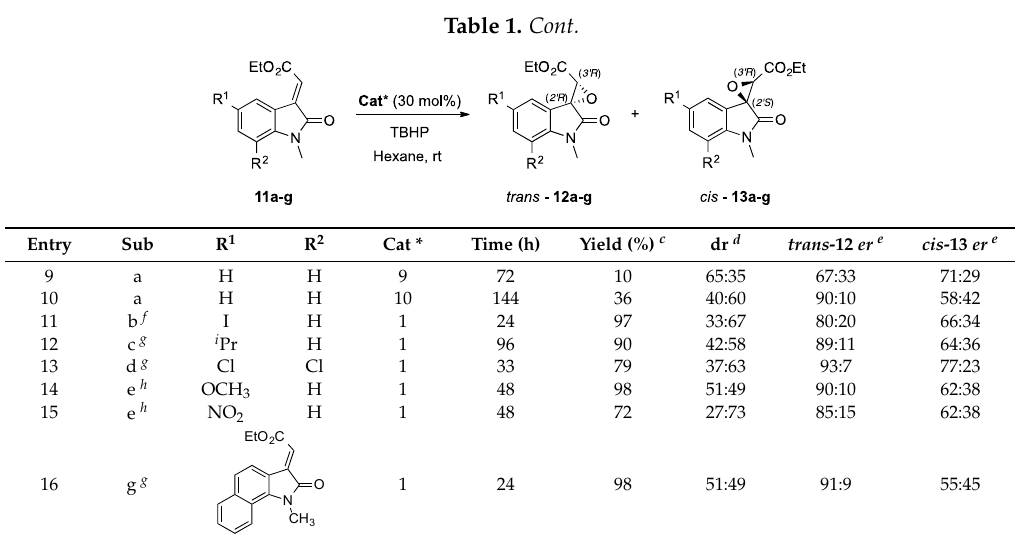
a Reaction conditions: N -Methyl α -ylideneoxindole 11 (0.5 mmol), catalyst 1 (0.15 mmol), THBP (0.6 mmol), and high-performance liquid chromatography (HPLC) grade hexane (2.7 mL) at rt. b The given stereochemical assignments are based on the previously reported data for spiroepoxides trans - 12a and cis - 13a [25]. c The yields of the isolated products are expressed as the sum of the diastereomers. d Determined by proton nuclear magnetic resonance ( 1 H-NMR) of the crude reaction mixture. e Determined by chiral-phase HPLC analysis. f For the already known α -ylideneoxyndole 11b see